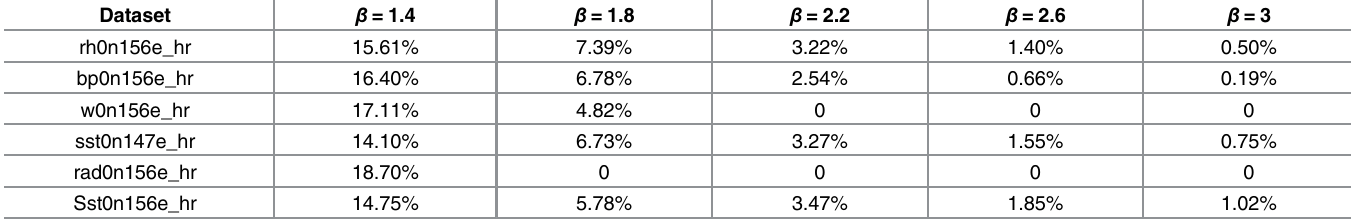
Table 4. P ( R b ) in different dominant range